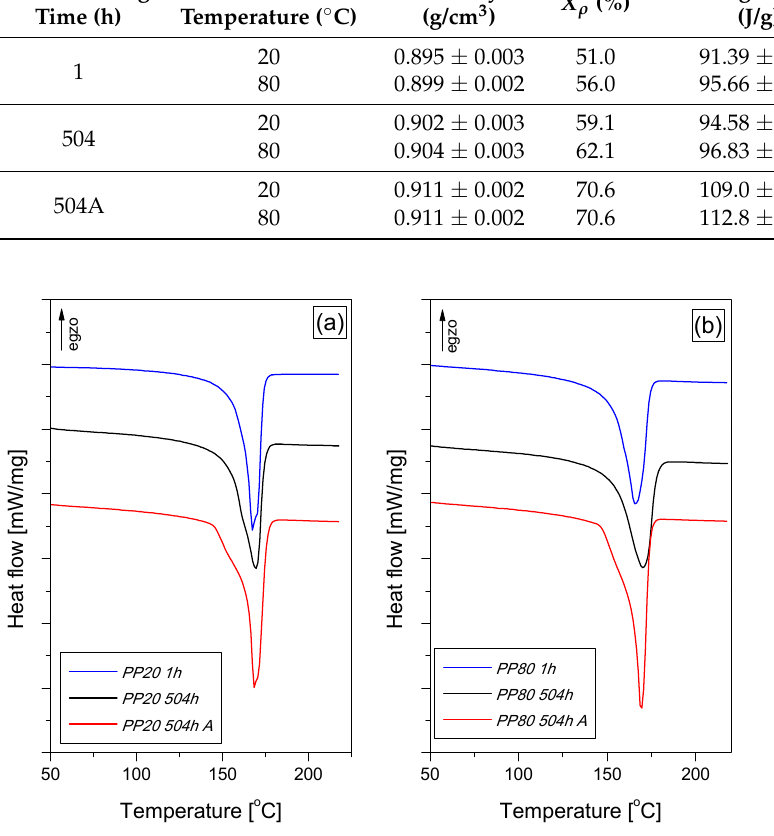
Figure 5. DSC melting curves of conditioned and annealed PP samples; PP20 ( a ), PP80 ( b ).